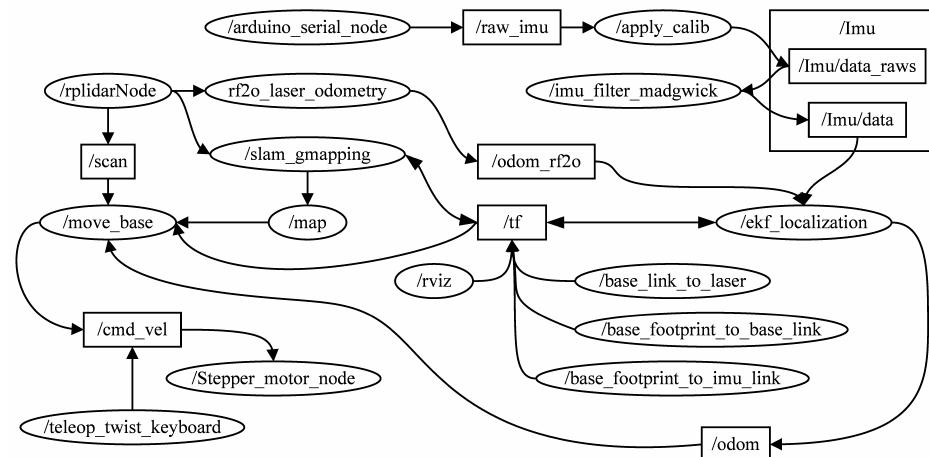
Figure 5. ROS topics and nodes associated with SLAM.